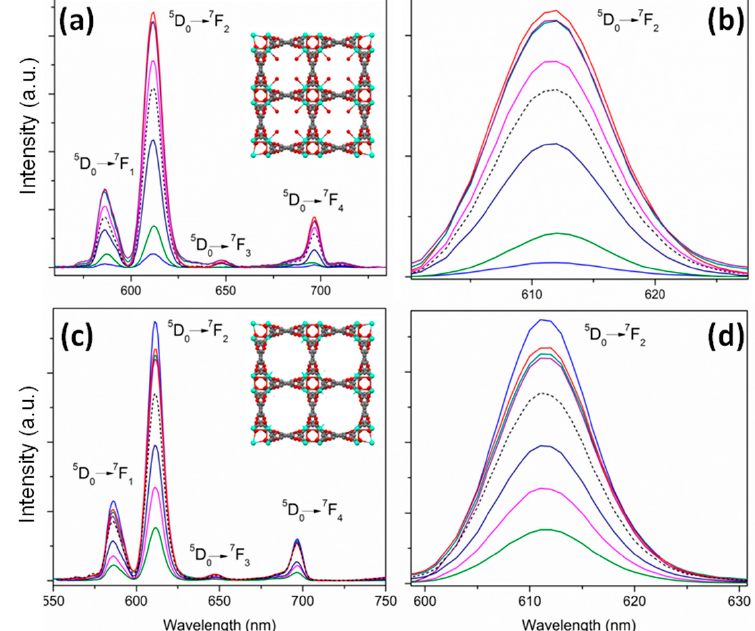
Figure 11. Emission spectra of X@Eu-BTC ( a ) and X@Eu-BTC’ ( c ) under diverse pollutant exposition (blue: MSM ; purple: CLM ; pink: CLP ; red: TOL ; dark yellow: IMZ ; olive: UO 22+; ; deep-blue: Cu 2+ ) ( a ). Black dashed line spectra correspond to those of Eu-BTC and Eu-BTC’ in methanol without analyte species. Zoomed region of the Eu 3+ hypersensitive 5 D 0 → 7 F 2 transition ( b , d ).